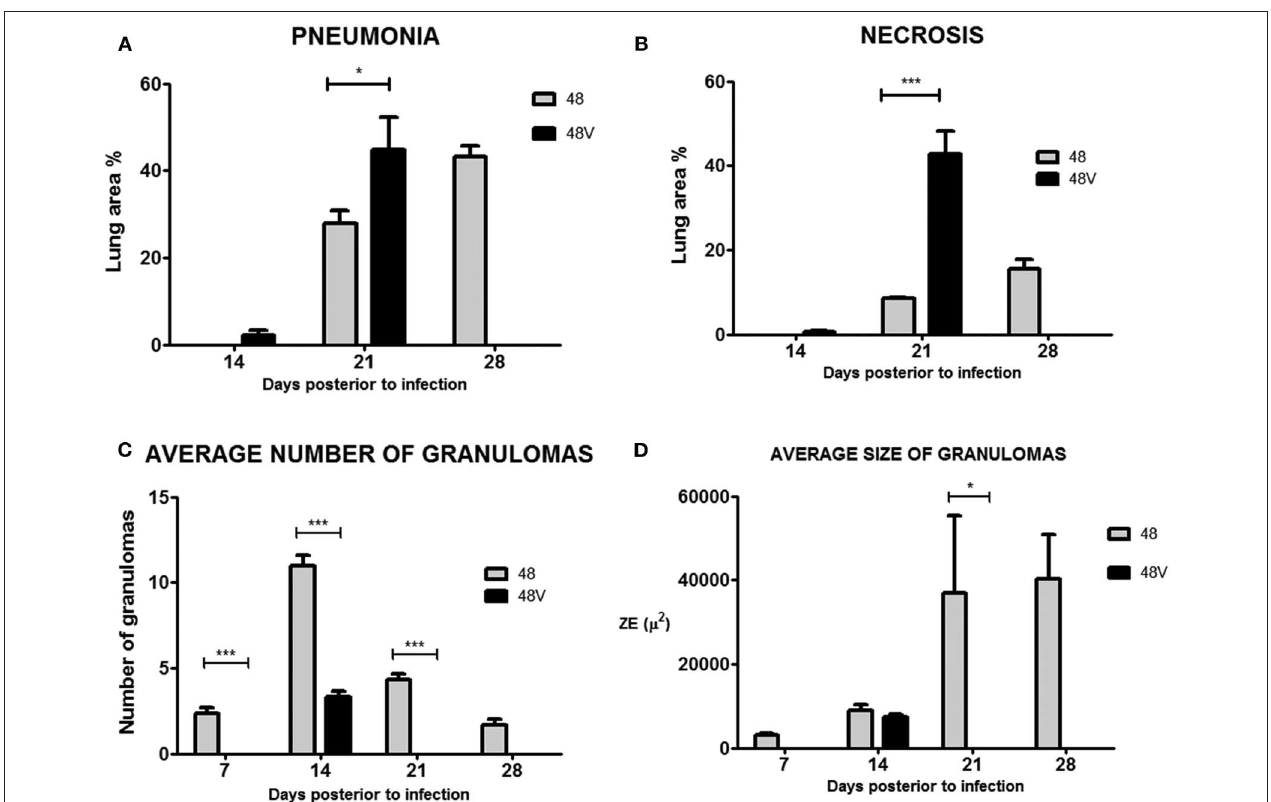
FIGURE 6 | (A) Lung area affected by pneumonia in animals infected by strain 48 and 48V. (B) Lung area affected by necrosis in animals infected by strain 48 and 48V. (C) Average number of granulomas in animals infected by strain 48 and 48V. (D) Average size of granulomas in animals infected by strains 48 and 48V. * p < 0.05, *** p <